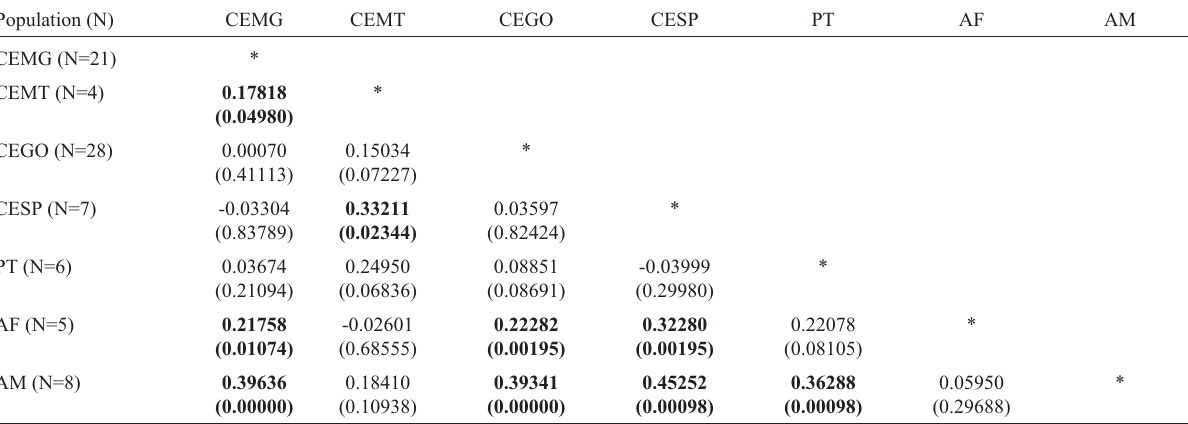
Table 4 - Pairwise F ST values for all populations analyzed. Significant values (p < 0.05) are displayed in parenthesis and highlighted in bold.